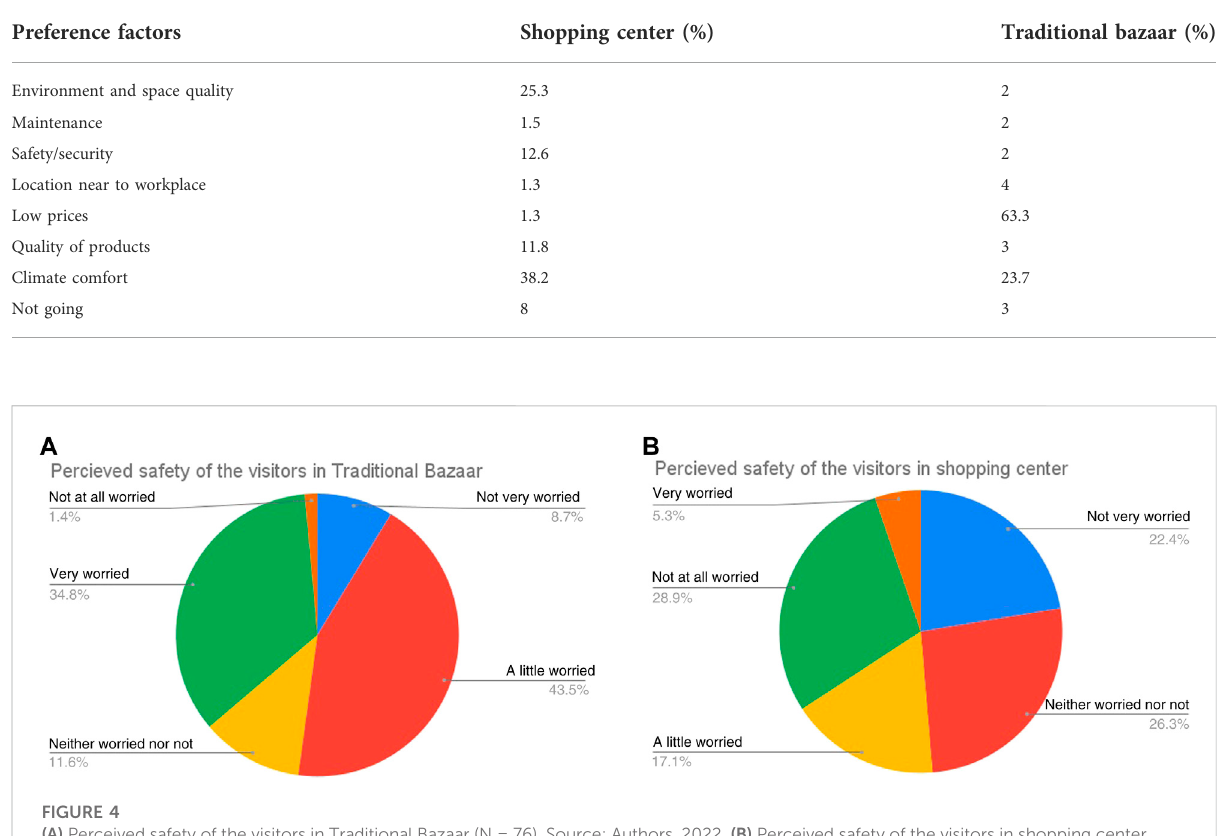
TABLE 3 Reason to visit shopping centers vs. Traditional bazaars.